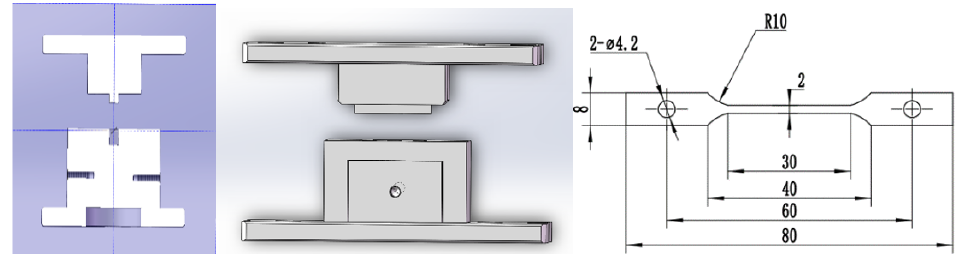
Figure 1. The die mold and tensile bar (All measures are shown in mm).